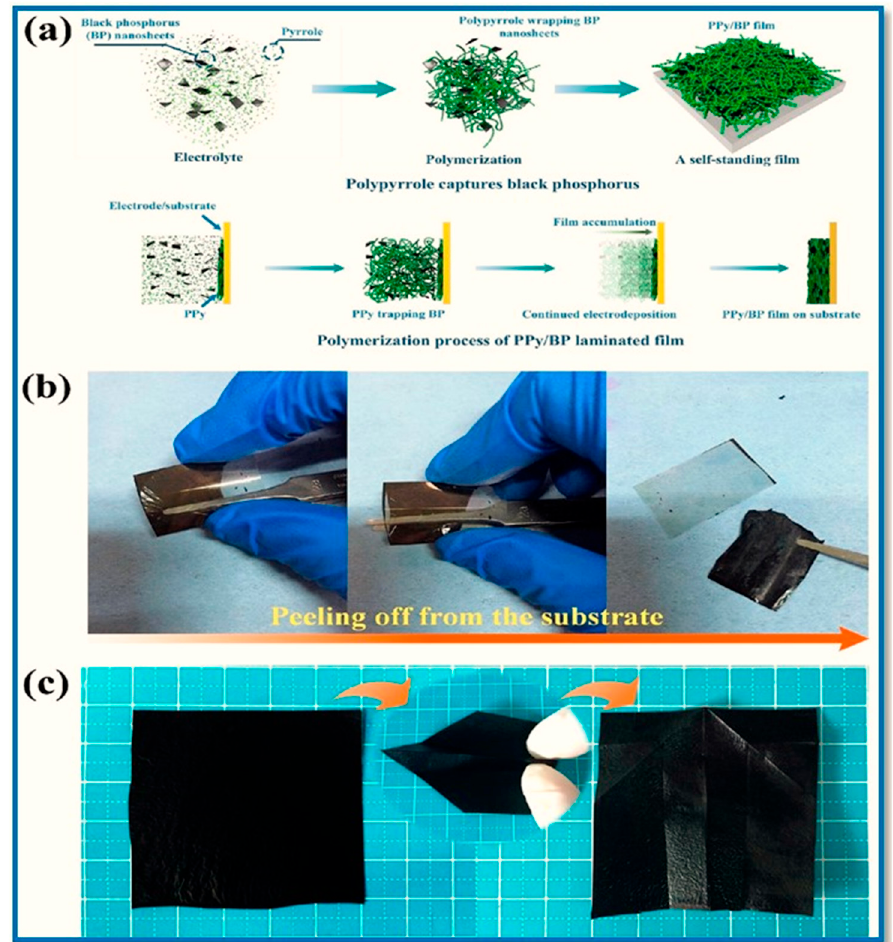
Figure 11. ( a ) The design and manufacturing process flow of self-standing PPy/black phosphorus (BP) laminated film. BP nanosheets were dispersed into electrolyte at the very beginning, and subsequently captured by PPy under electrodeposition process. Afterward, this hybrid film can be readily peeled off from substrate. ( b ) The demo of peeling off process of laminated PPy/BP film from PET substrate. ( c ) Photograph of a large-area self-standing PPy/BP laminated film with a size of 5 cm × 5 cm, which is robust enough and can be folded into a paper plane. Reprinted (adapted) with permission from {ACS Applied Materials and Interfaces [120], Copyright 2018 American Chemical